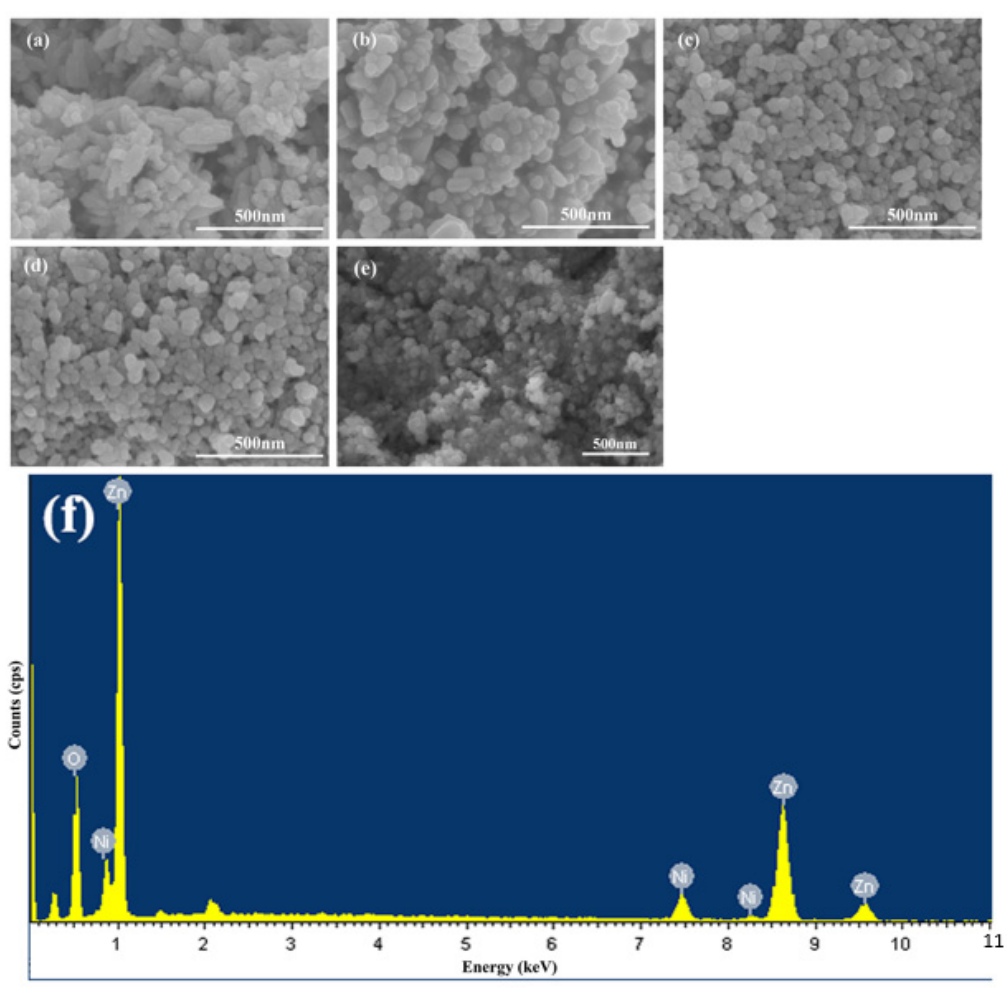
Figure 4. SEM images of ( a ) ZnO, ( b ) ZN-5, ( c ) ZN-10, ( d ) ZN-15, ( e ) OZN-10, and ( f ) EDS spectra of